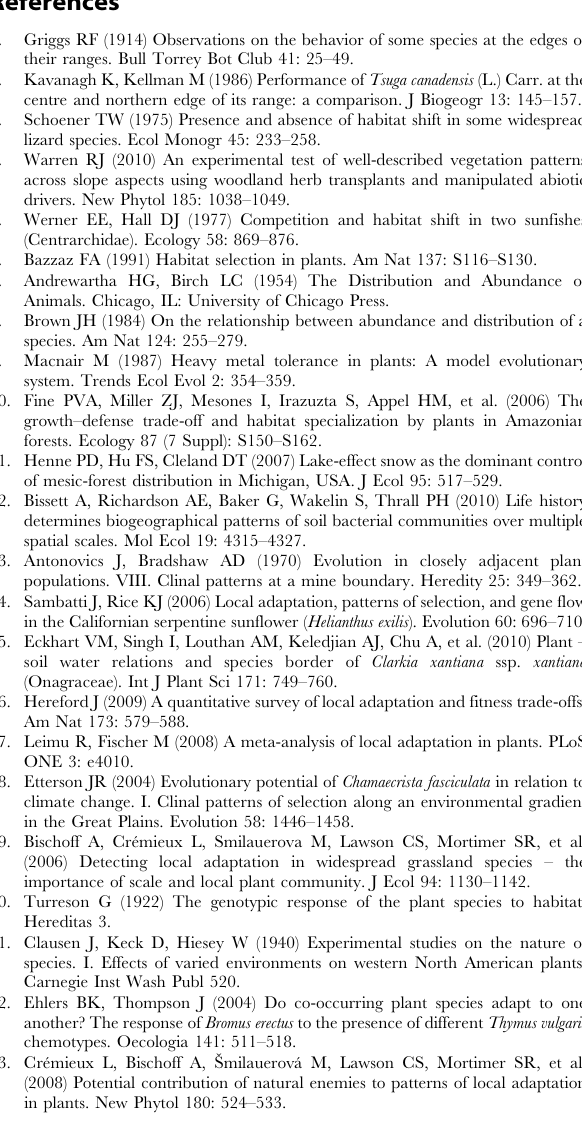
Figure S2 Mean proportion early-season survival ( ± SE) for each population at each site . Sand sites are on the left and loam sites are on the right. The interior sites are on the bottom, edge sites are in the middle and beyond edge sites are on the top. Populations are arranged from north (left) to south (right) in each plot. Table S1 C. fasciculata population source information and seeds planted at each transplant site . Populations are organized from north to south origin. Mean annual temperature (MAT) and annual precipitation (PPT) were collected from the WorldClim data set. Table S2 Transplant site locations, and climate and soil characteristics . Mean annual temperature (MAT) and annual precipitation (PPT) were collected from the WorldClim data